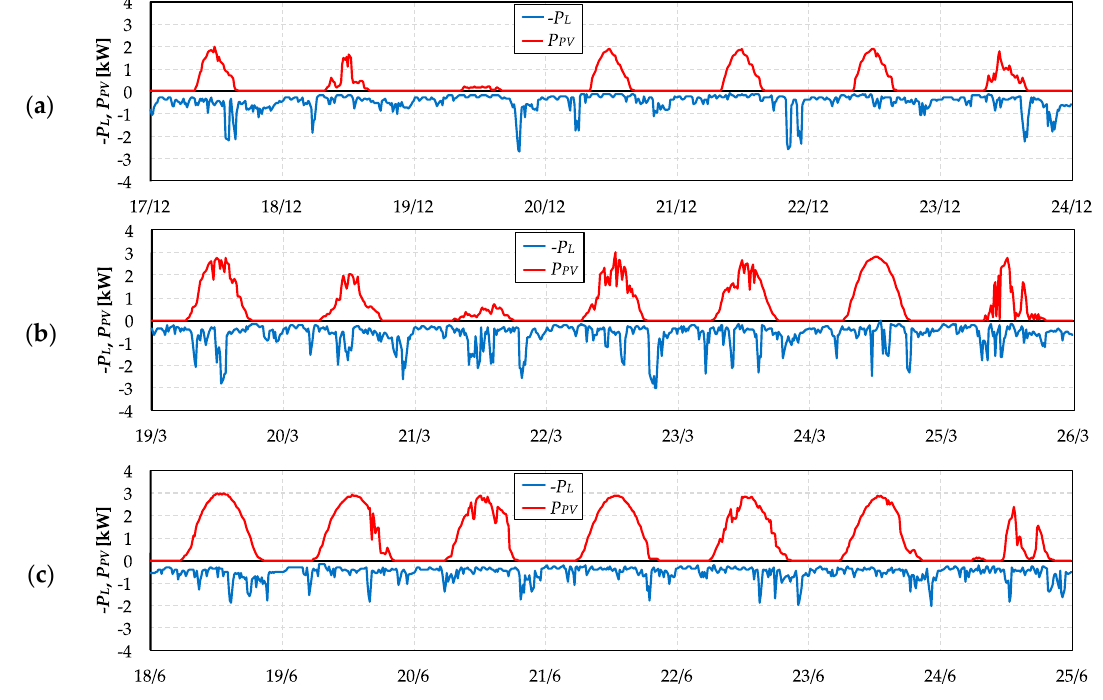
Figure 4. Representation of the weekly profiles of the load power consumption − P L ( t ) (blue lines) and the PV production ( P PV ( t ) = P I,AC ( t ) without BESS, red lines), for three typical seasons: ( a ) the third full week of December; ( b ) the third full week of March; and ( c ) the third full week of June. Sundays are reported as the last days of the depicted time windows.